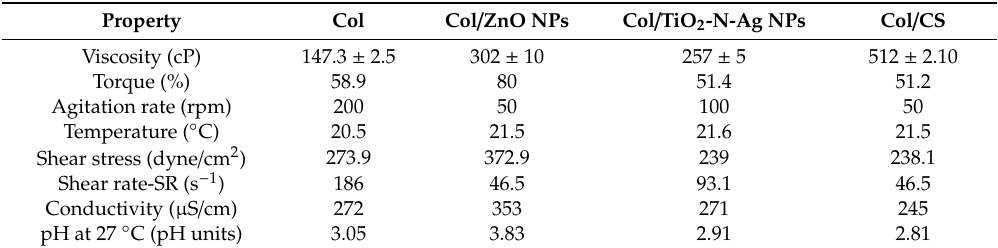
Table 1. Physical characteristics of antimicrobial collagen rabbit skin dispersions prior to processing by electrospinning